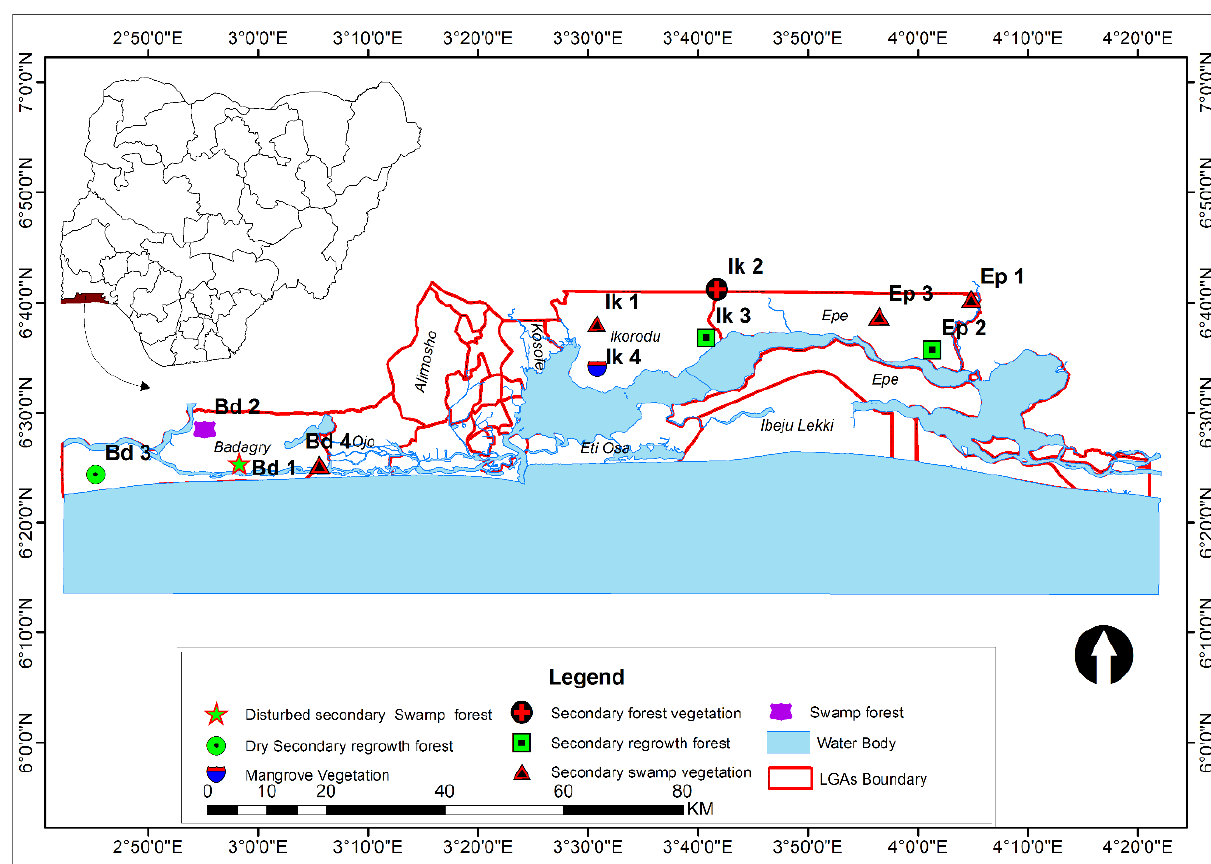
Figure 1. Map showing the selected study areas and respective sampling points within Lagos,